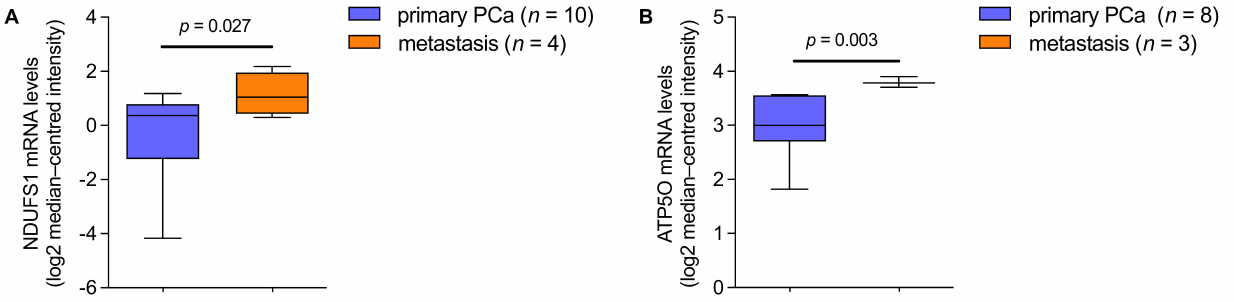
Figure A2. ( A ) NDUFS1 mRNA expression levels in prostate cancer patients, analyzed from primary PCa ( n = 10) and metastasis ( n = 4; 3.00-fold increase). ( B ) ATP5O mRNA expression levels in prostate cancer patients, analyzed from primary PCa ( n = 8) and metastasis ( n = 3; 1.75-fold increase). Data were extracted from the Oncomine™ Platform from the ( A ) Ramaswamy Multi-cancer and ( B ) Magee Prostate datasets. Representation: boxes as interquartile range, horizontal line as the mean, whiskers as lower and upper limits.